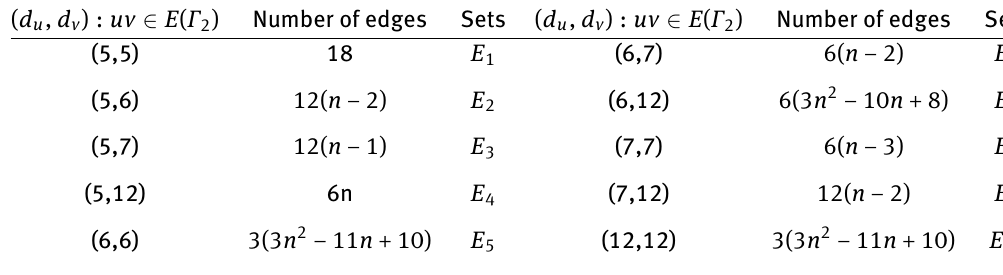
Table 3: Vertex degree based edge partitioning of a graph Γ 2